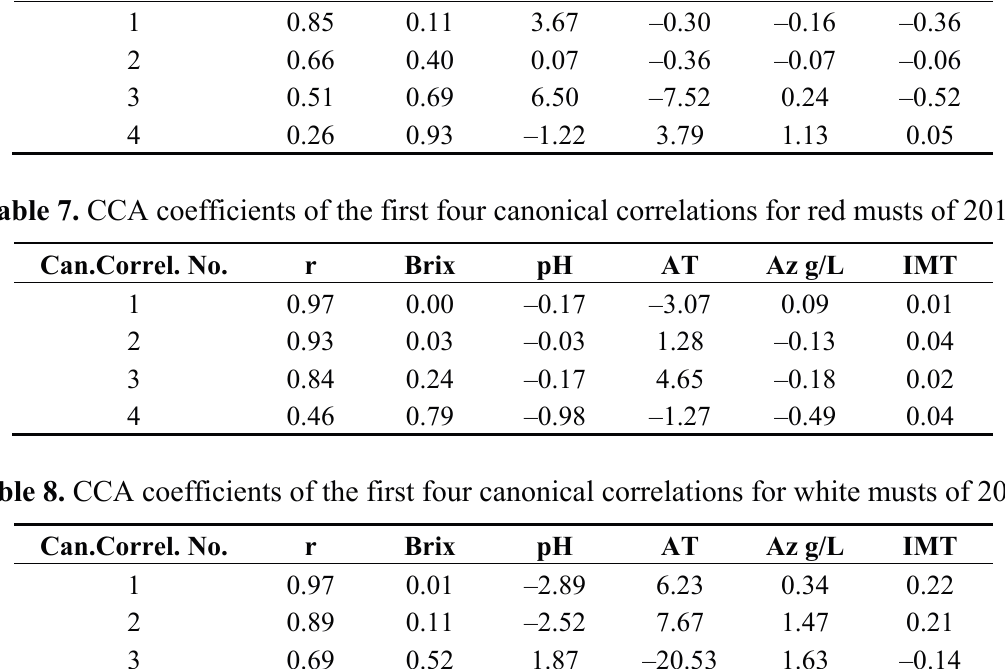
Table 6. CCA coefficients of the first four canonical correlations for white musts of 2011. Can.Correl. No.